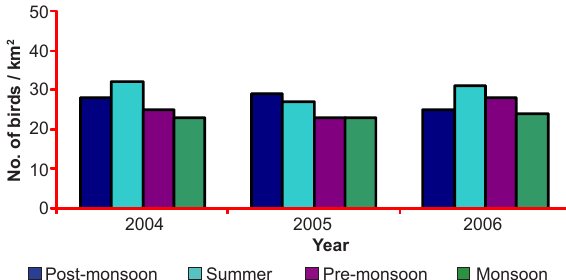
Figure 3. Habitat-wise variations in the density of the Indian Roller in social forests from 2004 to 2006